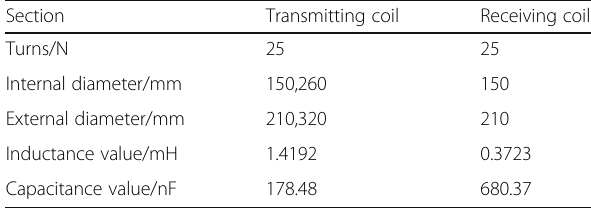
Table 3 Coil structure